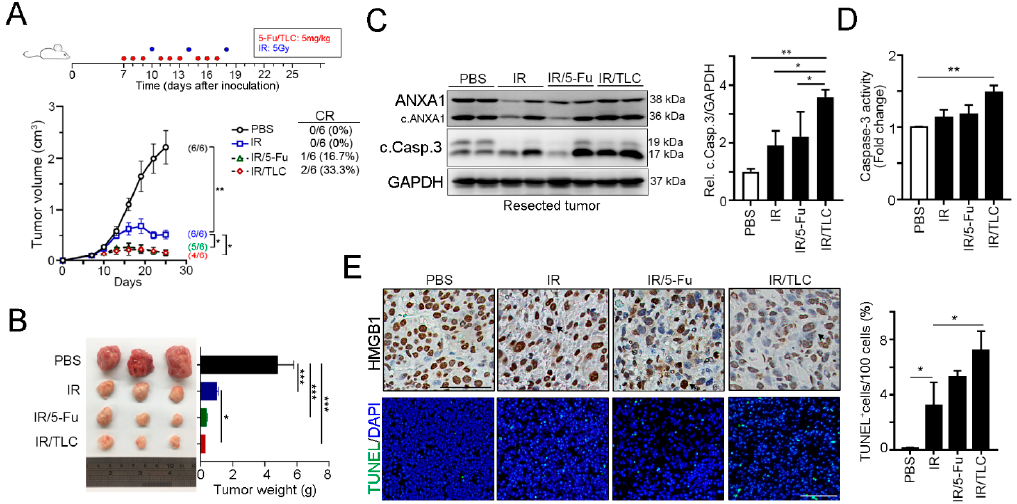
Figure 4. The TLC-based CRT regimen significantly suppressed tumor growth in vivo. ( A ) Tumor growth of CT26-driven colon carcinoma established in BALB/c mice ( n = 6 per group) that were treated with IR (5 Gy for 3 fractions), IR/5-Fu (5-Fu: 5 mg/kg) and IR/TLC (TLC: 5 mg/kg). Tumor growth is reported as the mean tumor volume ± SEM. over time. * p < 0.05 and ** p < 0.01. CR: complete response. ( B ) The weight of resected tumors was examined ( n = 3). * p < 0.05 and *** p < 0.001. ( C ) Resected tumors were extracted, and the protein levels were analyzed by immunoblotting ( n = 3). ( D ) Caspase-3 activity was measured by caspase-3 activity assay ( n = 3). ** p < 0.01. ( E ) The representative results of HMGB were analyzed by immunohistochemistry ( n = 3), and the extent of cell death was measured by TUNEL assay ( n = 3). * p < 0.05. More details of western blot, please view at Figure S5. Cancers 2021 , 13 , x